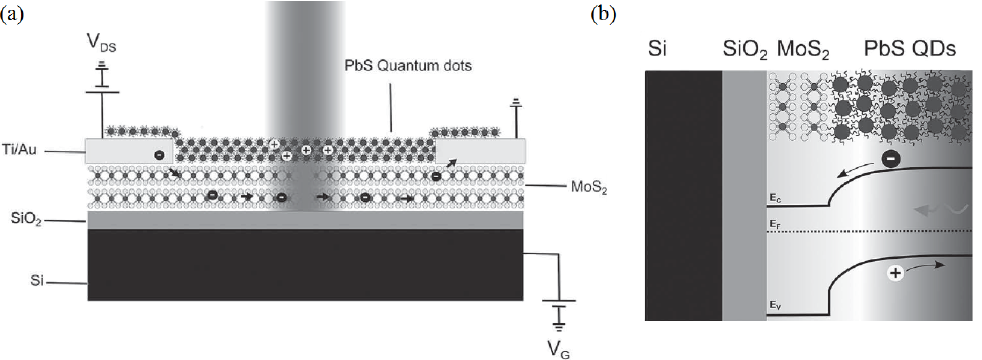
Figure 3. ( a ) Device structure of a hybrid quantum dot/MoS 2 photodetector. Reproduced with permission from [57], Copyright John Wiley and Sons, 2014. ( b ) Schematic drawing of the charge separation at the quantum dot/MoS 2 interface. Reproduced with permission from